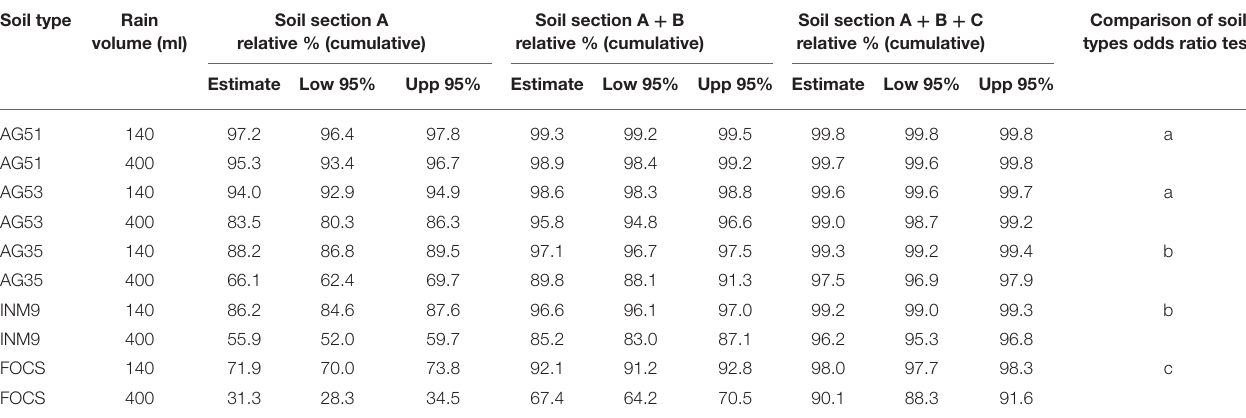
TABLE 2 | Relative percentages (cumulative values) of conidia at different soil sections and soil types. Soil